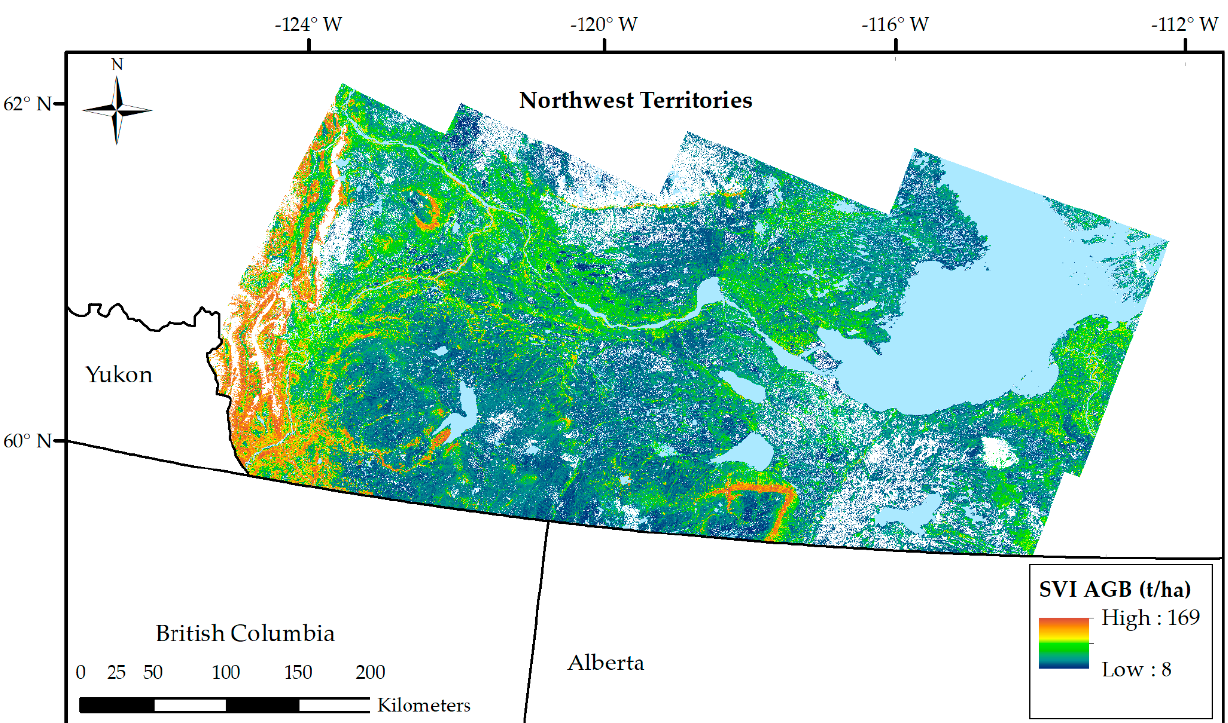
Figure 6. SVI raster maps from k -NN predictions of ( a ) stand height and ( b ) AGB for the Phase 1 area. White pixels are non-forested lands, whereas light blue pixels are water bodies. Low and high attribute values are the 5% and 95% percentile, respectively. SVI maps for all five forest attributes are found in Figure S2.